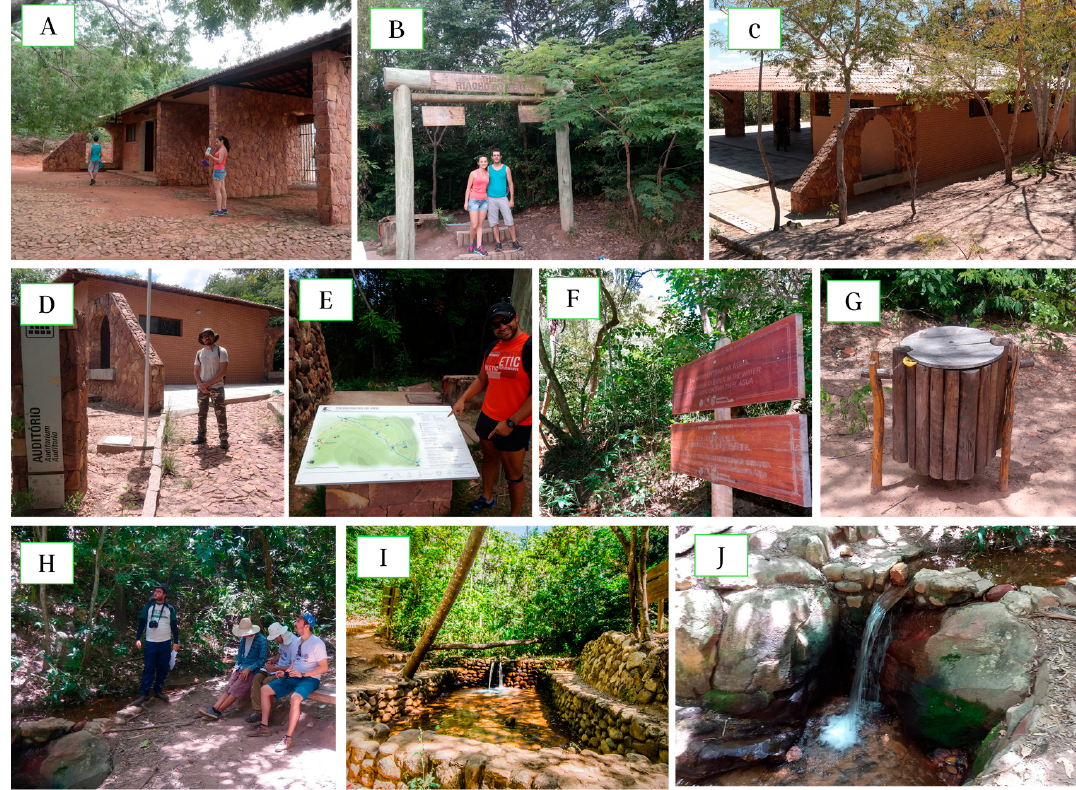
Figure 9. Riacho do Meio trail and geosite infrastructure; Araripe UGG. Source: Research Collection. ( A )—Parking and a guardhouse; ( B )—Stone and wood projected trails; ( C )—Restaurant, ( D )—Auditorium, ( E , F )—Signage and internal communication, ( H )—Rest areas; ( G )—Anti-fauna waste baskets; ( I )—Rustic pools; ( J )—Springs with drinking water.